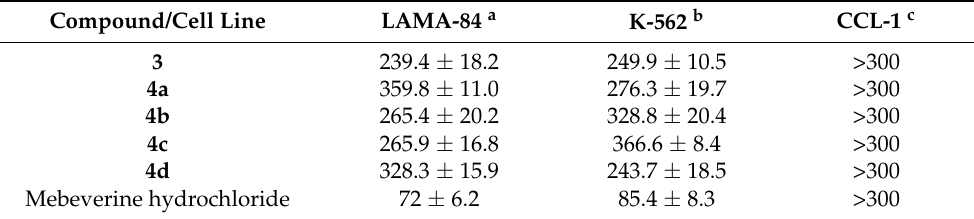
Table 4. In vitro cytotoxicity of the tested compounds [ µ M ± SD] against cell lines of different origin. Compound/Cell